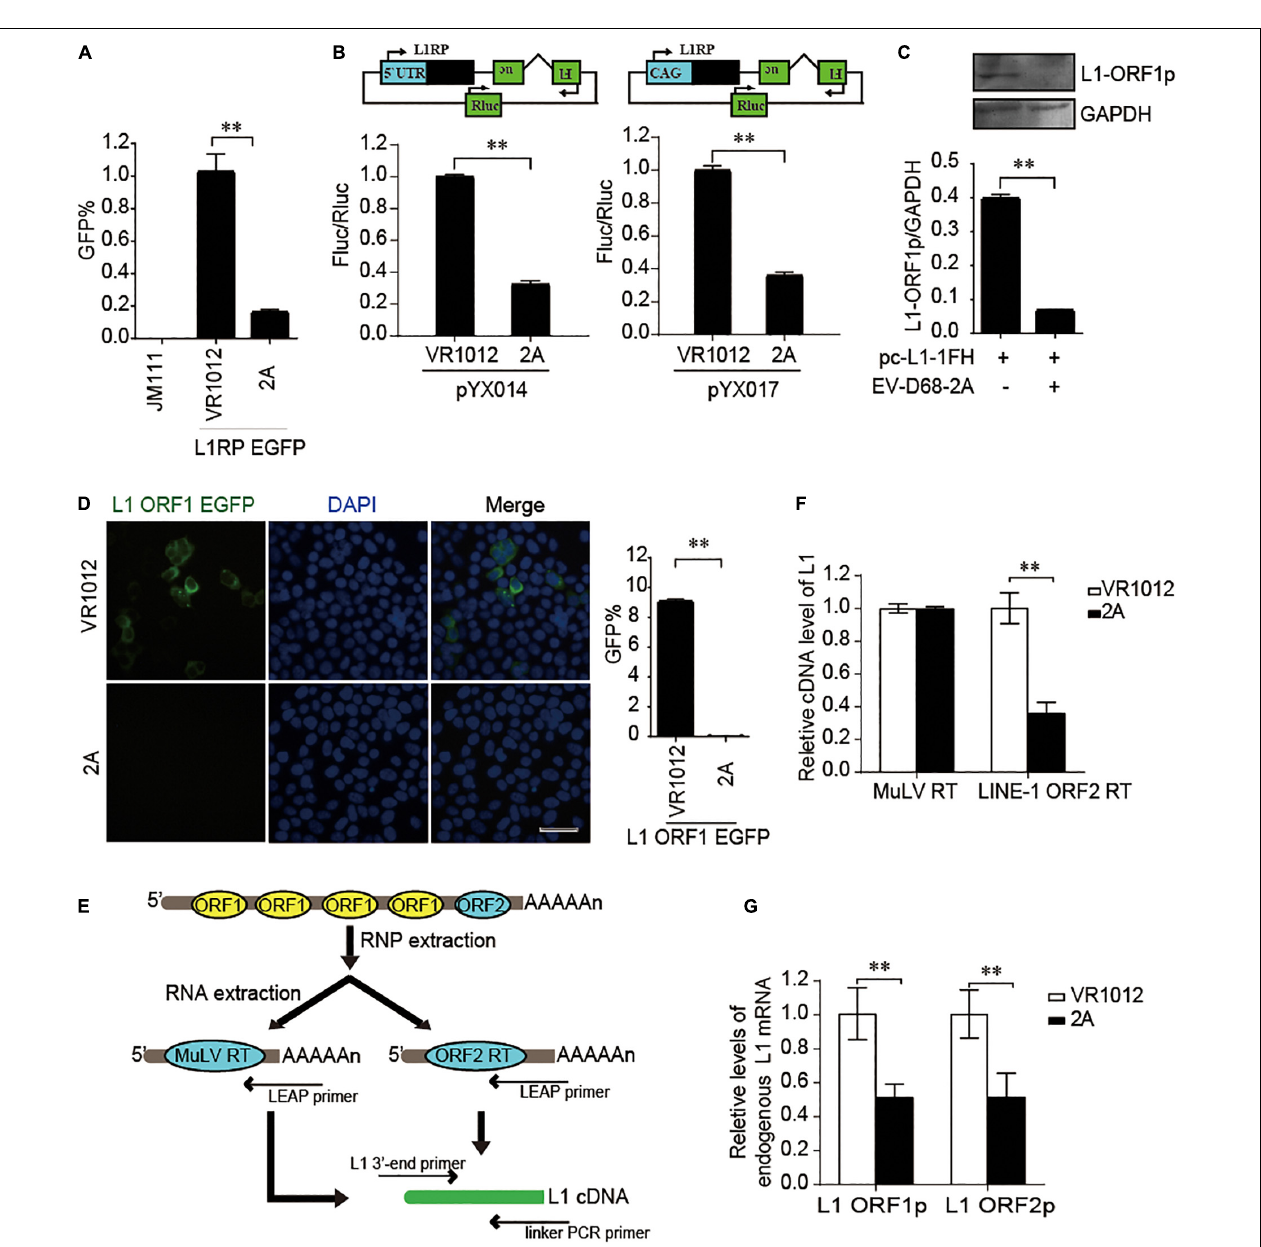
FIGURE 3 | EV-D68 2A modulates LINE-1 retrotransposition in an ORF1p and ORF2p dependent manner. (A) L1RP EGFP plasmids and empty vector VR1012 or EV-D68 2A expressing construct were co-transfected into HEK293T cells. JM111 was used as a negative control. Flow cytometry was performed 4th day post-transfection. The bar graph depicts the M ± SD of each experiment, performed in triplicate The asterisks indicate statistically significant differences between groups by Unpaired Student’s t -test ( p < 0.01). (B) Empty vector VR1012 or EV-D68 2A expressing construct was co-transfected with the pYX014/pYX017 construct into HEK293T cells. Dual-Luciferase assays were performed according to the manufacturer’s instructions 96 h post-transfection. The bar graph of Firefly and Renilla luciferase ratio represents the retrotransposition frequency, with the VR1012-transfected sample set to 1.0. The asterisks indicate statistically significant differences between groups by Unpaired Student’s t -test ( P < 0.01). (C) VR1012 or VR1012-2A plasmids were co-transfected with pc-L1-1FH. Anti-HA antibodies immunoblotted the cell lysate. (D) HEK293T cells were transfected with pEGFP-N1-ORF1-EGFP and VR1012 or VR1012-2A plasmids. Immunostaining and fluorescence imaging were performed as described in the “Materials and Methods” 48 h post-transfection: scale bar, 20 µ m. Bar graph represents the percentage of GFP-positive cells from flowcytometry. The asterisks indicate statistically significant differences between groups by Unpaired Student’s t -test ( p <